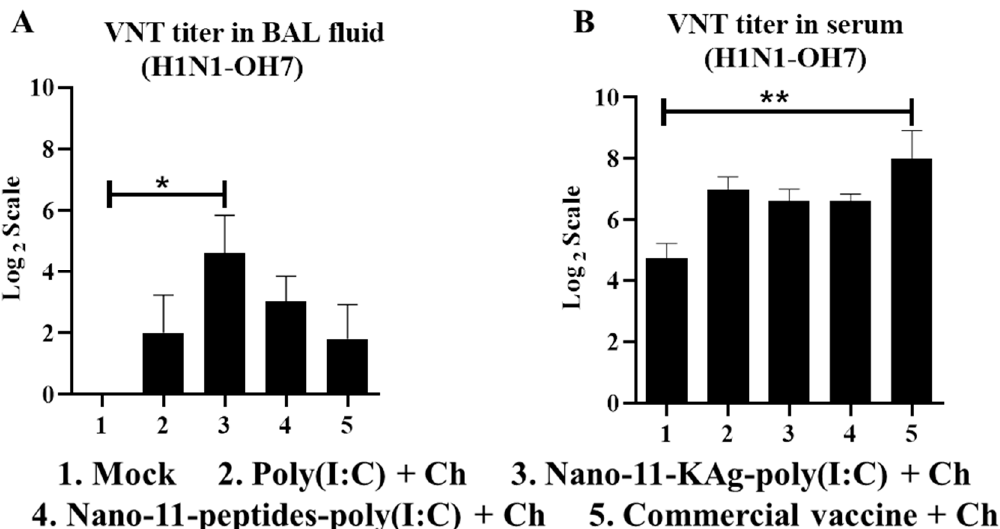
Figure 6. Nano-11-KAg-poly(I:C) and commercial influenza vaccines induced increased virus neutralization test titers in BAL fluid and serum of pigs, respectively. The H1N1-OH7 challenge virus- specific virus neutralization antibody titer in ( A ) BAL fluid; and ( B ) Serum samples collected at post- challenge day 6. Data represent the mean value of four to five pigs ± SEM. Statistical analysis was carried out using one-way analysis of variance followed by Tukey’s post hoc comparison. Asterisk refers to statistical difference between the two indicated groups (* p < 0.05, and ** p < 0.01). Ch— Challenge.